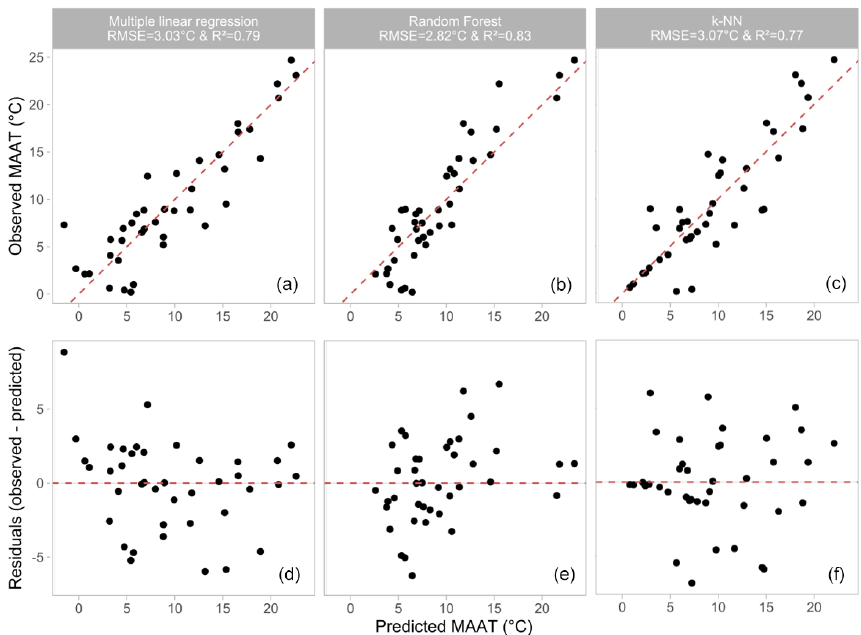
Figure 7. Results of the three different models tested to reconstruct the MAAT from 3-OH FA distribution: observed MAAT ( ◦ C) vs. predicted MAAT ( ◦ C) for (a) the multiple linear regression model, (b) the random forest model and (c) the k -NN method. MAAT residuals plotted against the predicted MAAT for (d) the multiple linear regression model, (e) the random forest model and (f) the k -NN